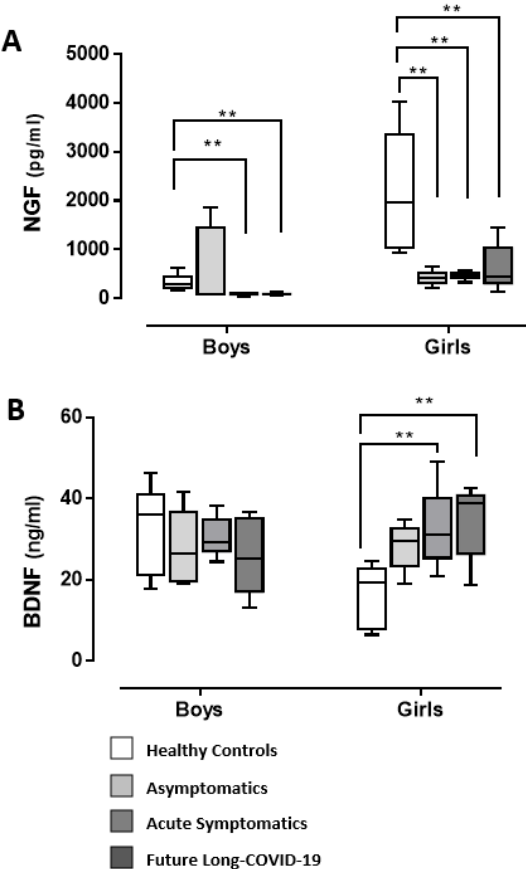
Figure 1. Serum NGF ( A ) and BDNF ( B ) in COVID-19 adolescents and healthy controls. According to their COVID-19 related outcomes, the recruited individuals were divided into 3 groups: asymptomat- ics, acute symptomatics, and symptomatics that over time developed long-COVID-19 symptoms (“future long-COVID-19”); as a control group we analyzed the serum of age-matched healthy controls that did not contract the infection. Boxes indicate the lower and upper quartiles. The vertical lines extending from each box represent the minimum and maximum values. The asterisks indicate significant differences between groups (** p <